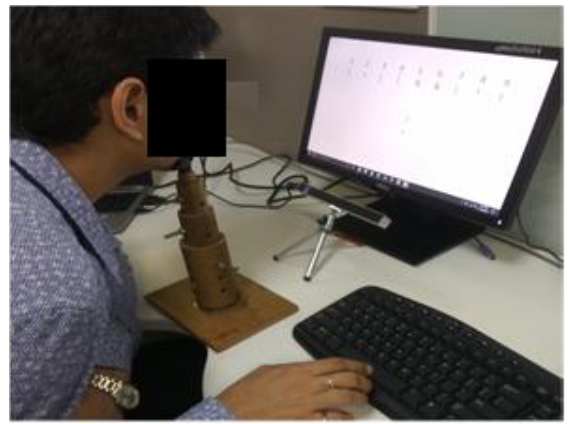
Fig. 5 Experimental